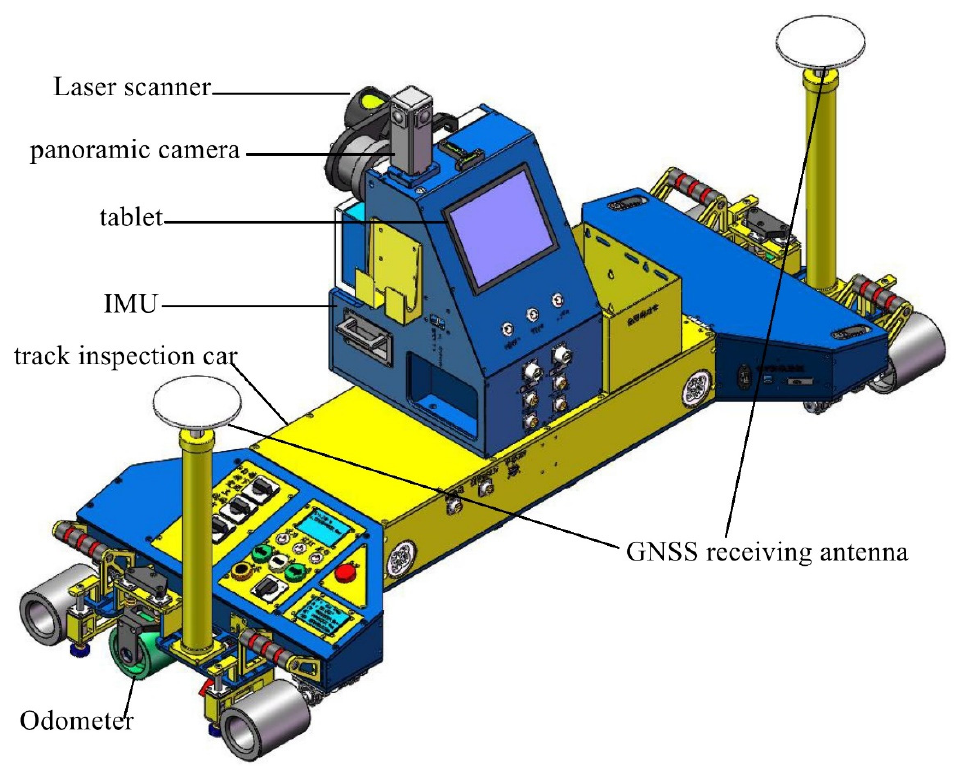
Figure 1. Schematic diagram of the mobile railway inspection vehicle, including a laser scanner, IMU, GNSS antenna, a tablet, an odometer, and the panoramic camera.